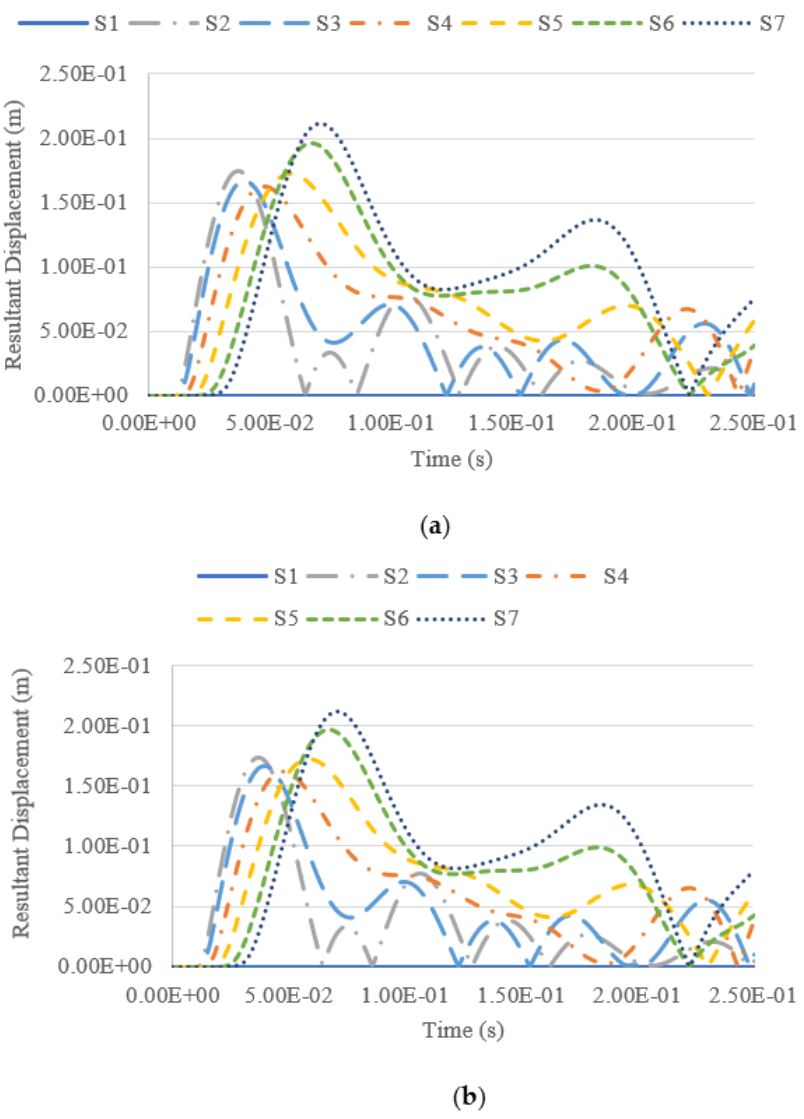
Figure 16. Resultant displacement versus time under blast intensity of 380 kg TNT equivalent mass 12.5 m away, ( a ) 100% fill and ( b ) 0% fill.